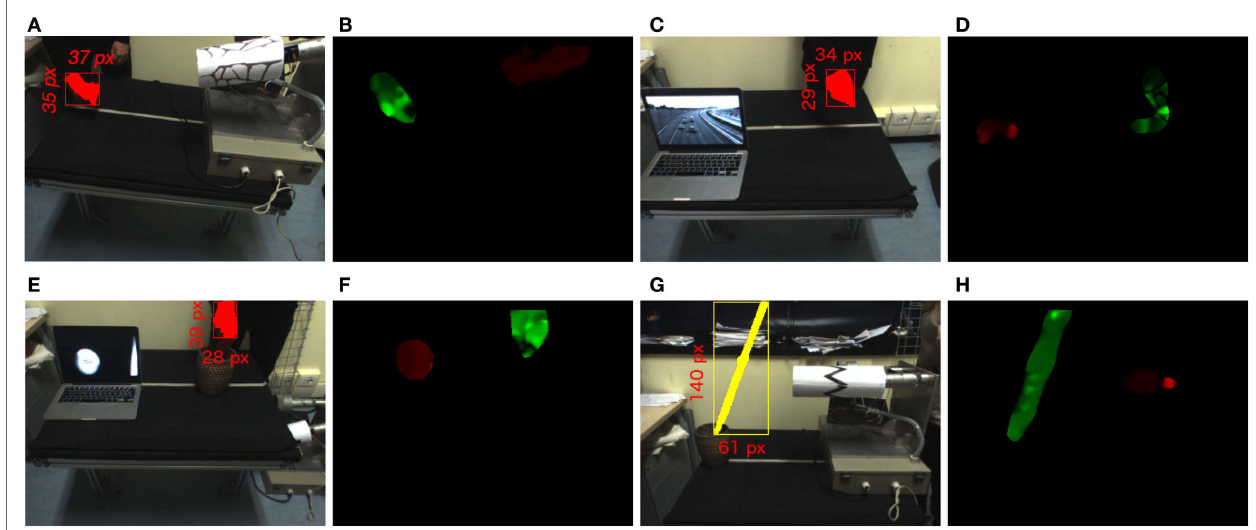
FIGURE 7 | (A,C,E,G) Representation of the setup and color segmentation for biological motion samples. (B,D,F,H) Biological (green) and non-biological (red) movements detected in panels (A,C,E,G) .